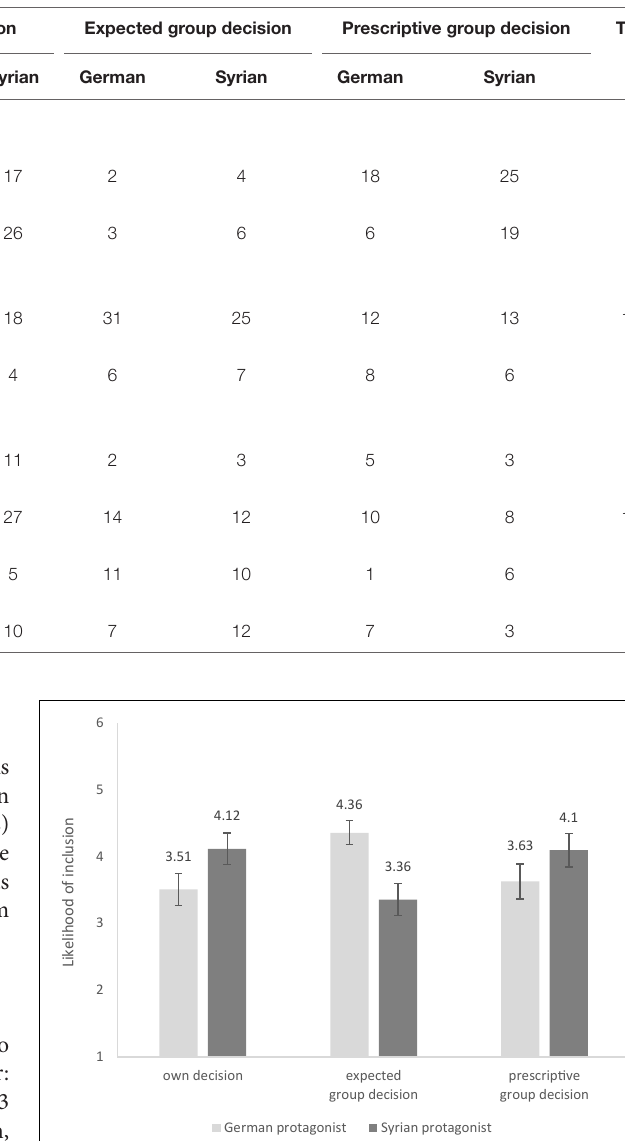
TABLE 1 | Coding system and frequencies of usage.